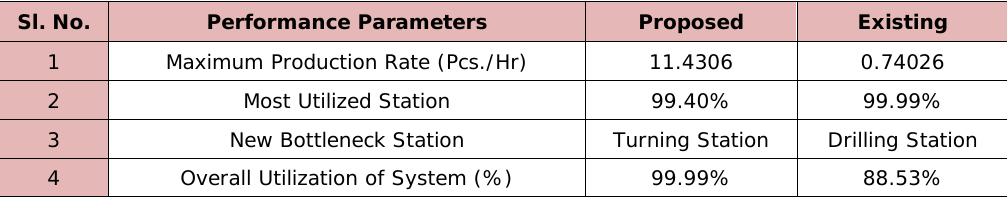
Figure 5. “FMS Utilization (Proposed vs. Existing)”. Source: Own contribution